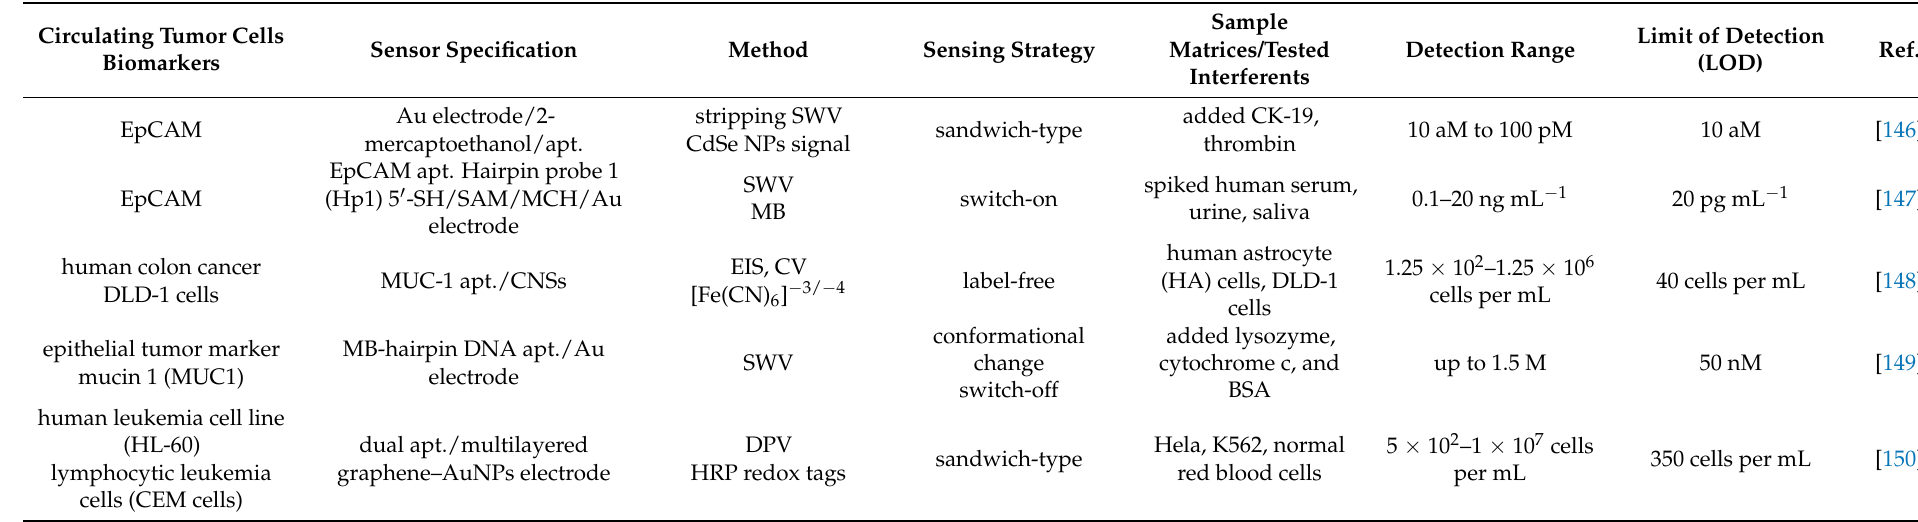
Table 7. Specifications and electrochemical performance of aptasensors for circulating tumor cells